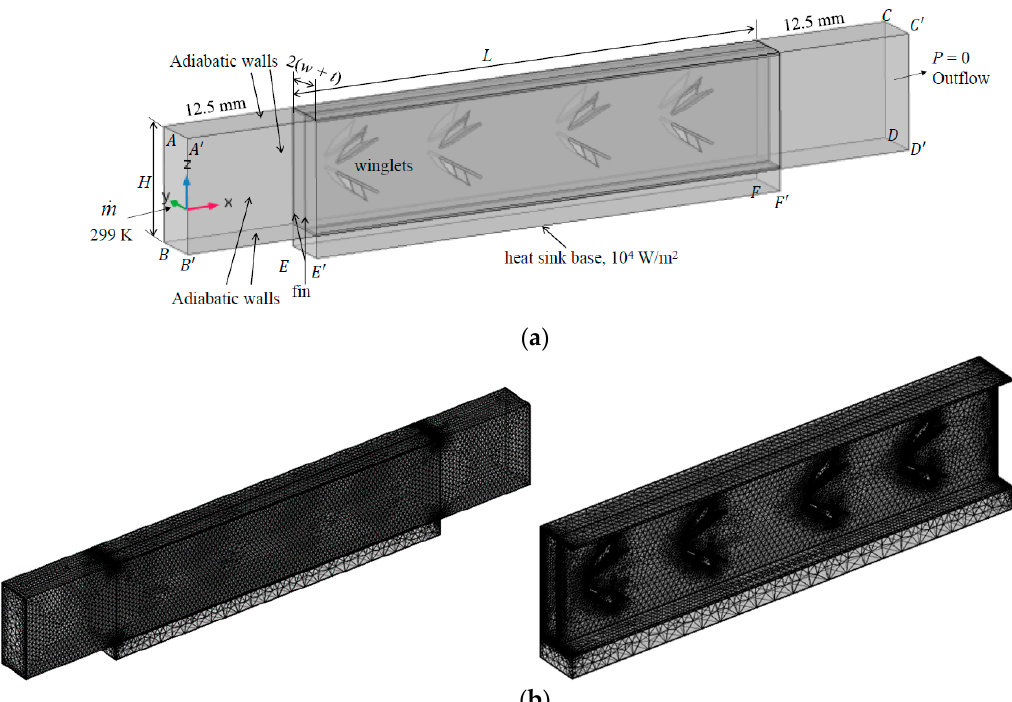
Table 2. Uncertainty of the measured value in this study. Parameter